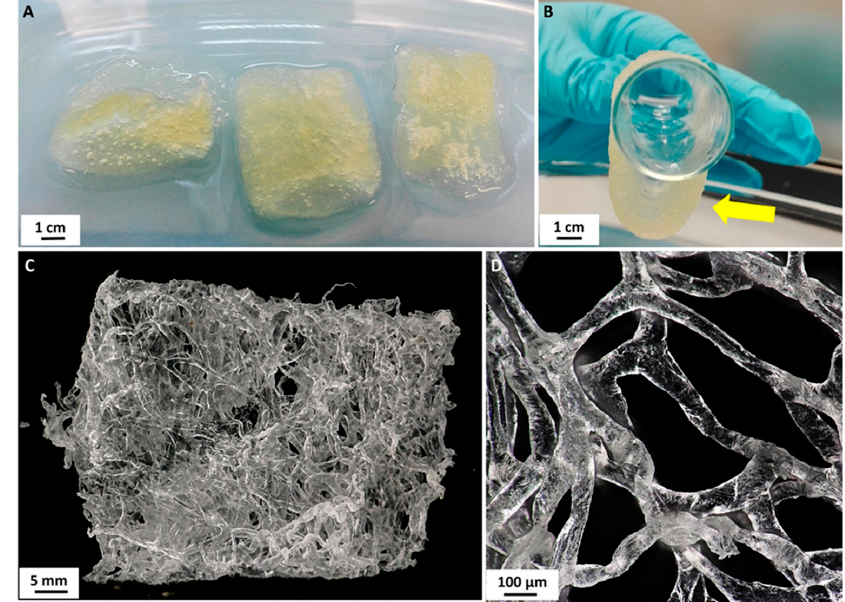
Figure 2. Isolated chitinous scaffolds ( A ) possess excellent ability to insert water ( B , arrow). On drying in air at ambient temperature these constructs remained three-dimensional ( C ) and retained their characteristic interconnected microtubular architecture ( D ).